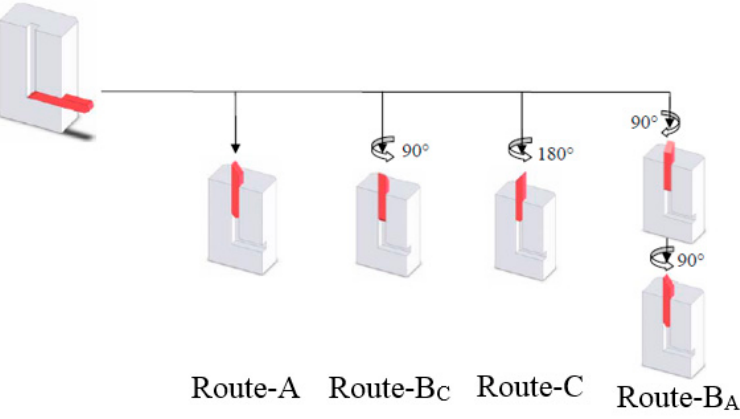
Figure 4. ECAP Routes [47].